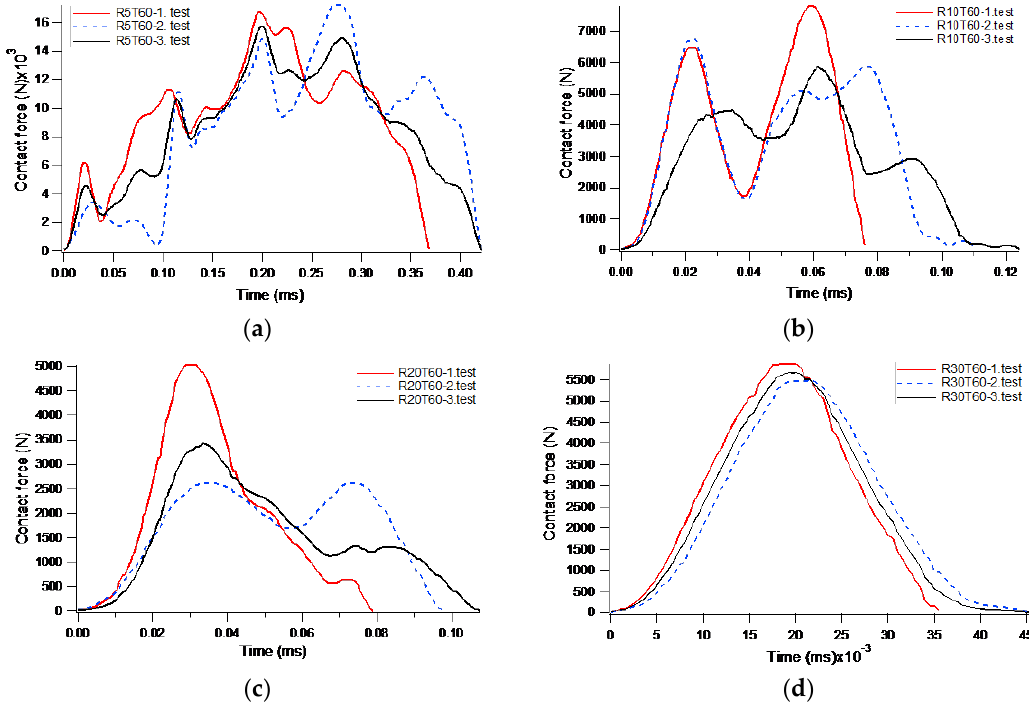
Figure 11. Contact force versus time (F−t) curves after repeating impact tests of composites sintered for 60 minutes: ( a ) Fe + 5 vol.% B 4 C (R5T60); ( b ) Fe + 10 vol.% B 4 C (R10T60); ( c ) Fe + 20 vol.% B 4 C (R20T60); ( d ) Fe + 30 vol.% B 4 C (R30T60).